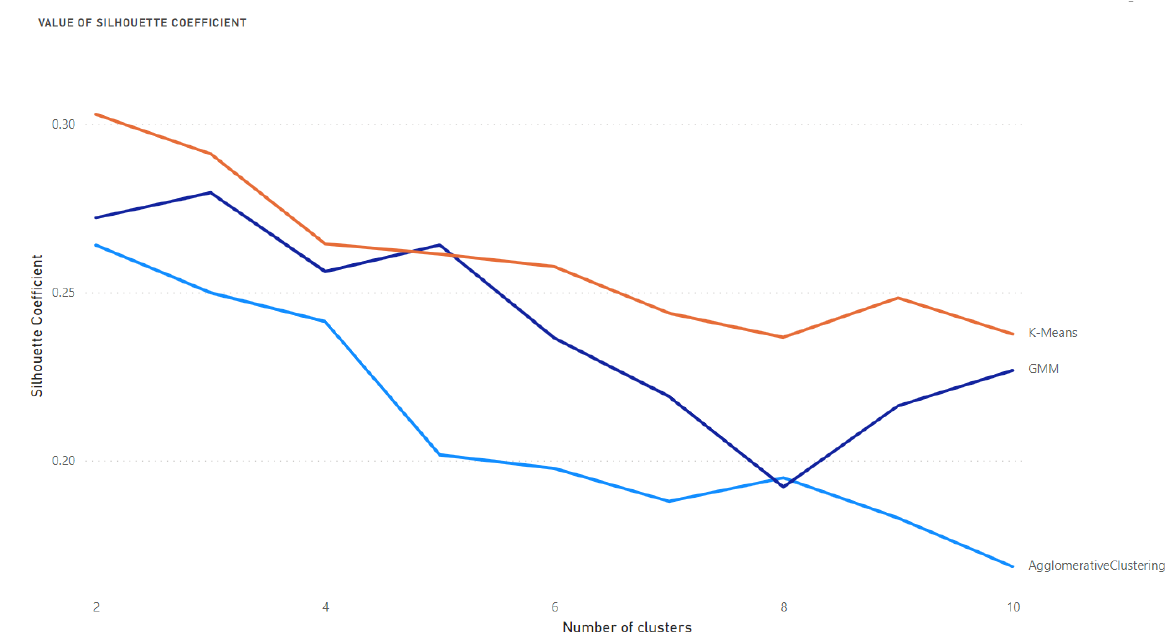
Figure 1. Silhouette coefficient for 3 selected algorithms and the various number of clusters.